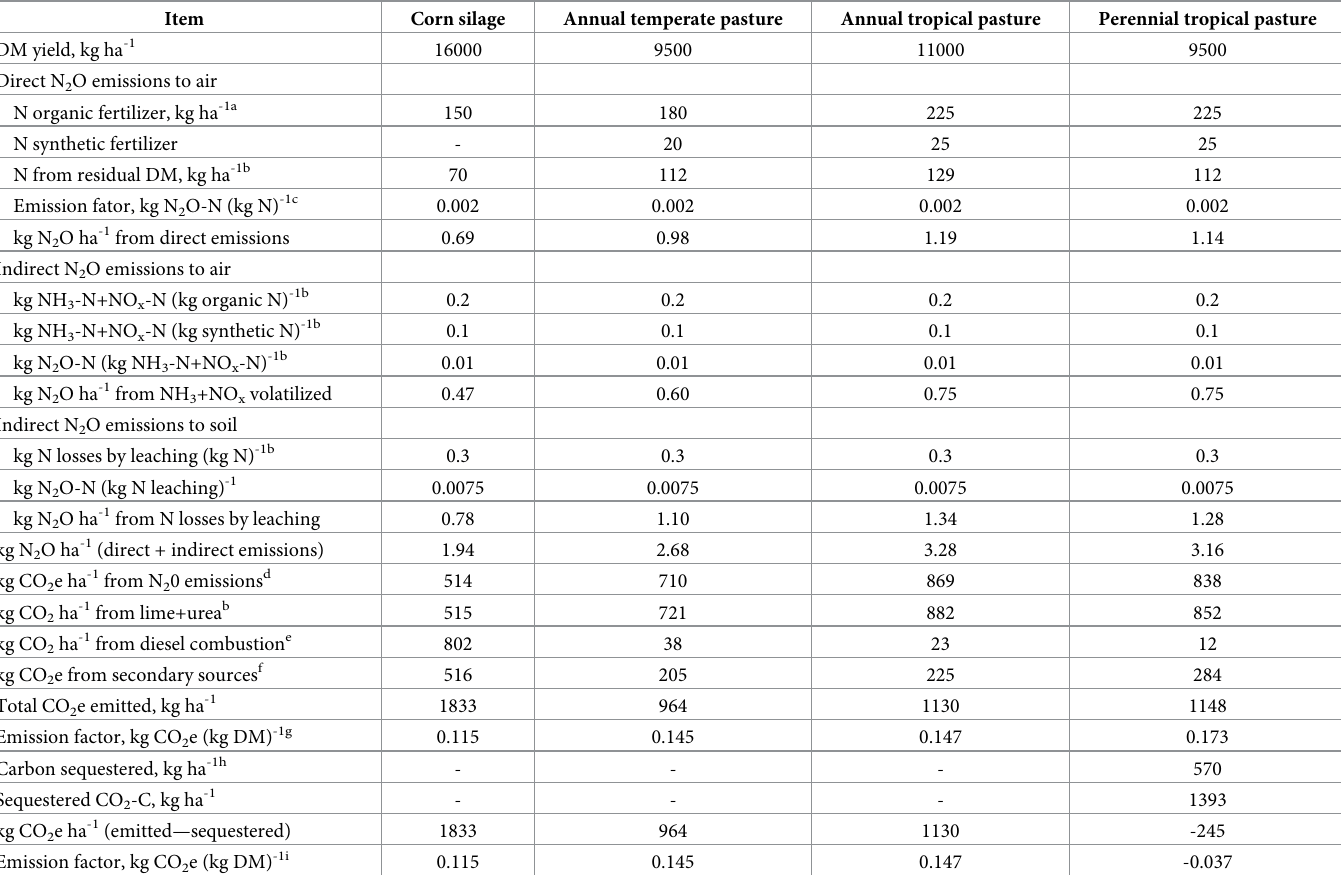
Table 4. GHG emissions from On-farm feed